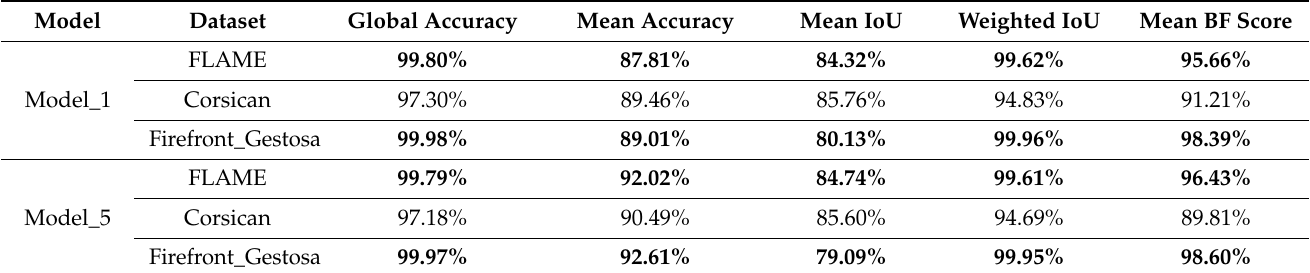
Table 7. The observed metrics over every set of data for Model_1 and